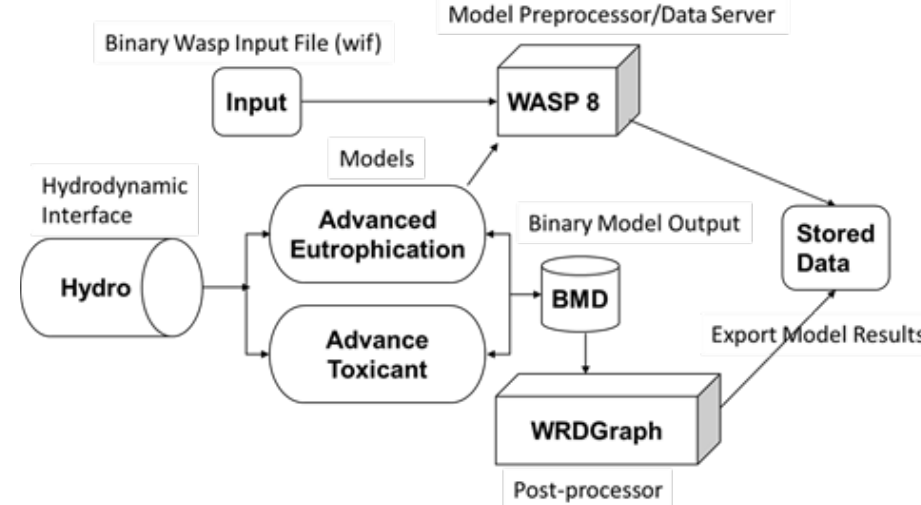
Figure 2. Components and the assembly of WASP8 model.